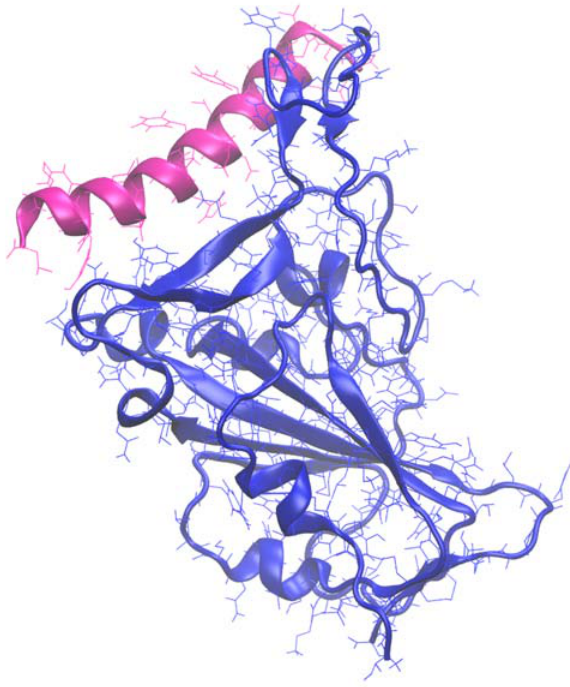
Fig. 2. Cartoon representation of the structure of the SARS­CoV­2 spike protein S1 with bound peptide STIEEQAKTFLDKFNHEAEDLFYQSSL, corresponding to the sequence 19–45 of the receptor protein ACE2. The complex structure was built computationally using molecular dynamics method and structural data listed in the PDB database (www.pdb.org) as “6LZG”. The spike protein is coloured blue and the peptide 19–45 is coloured